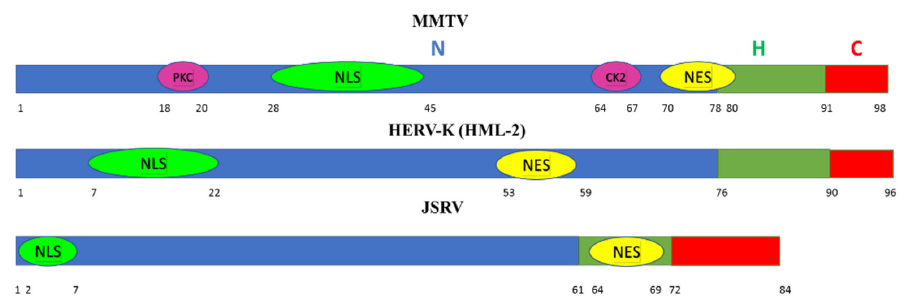
Figure 4. Tripartite composition of the three extended Betaretroviral signal peptides: MMTV, HERV ‐ K (HML ‐ 2) and JSRV. Shown are relative positions of the different domains, N (Blue), H (Green) and C (Red), as well as selected positions of functional sequences; PKC and CK2 phosphorylation sites; NLS—Nuclear Localization Signal; NES—Nuclear Export Signal.